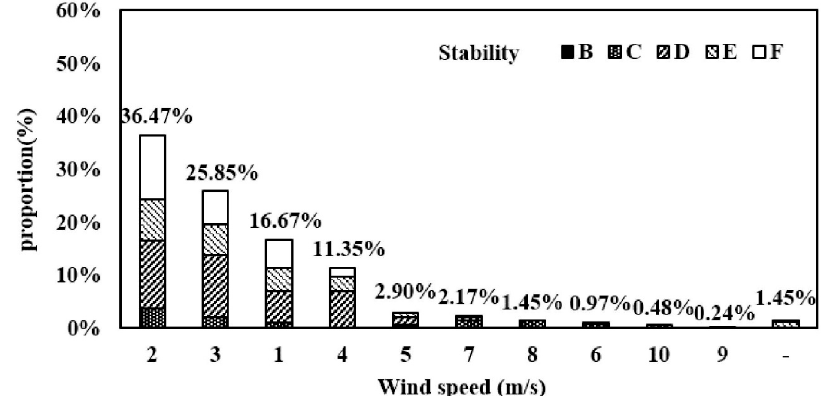
Figure 3. Comprehensive meteorological statistics in wind speed and atmospheric stability for pollution episodes.